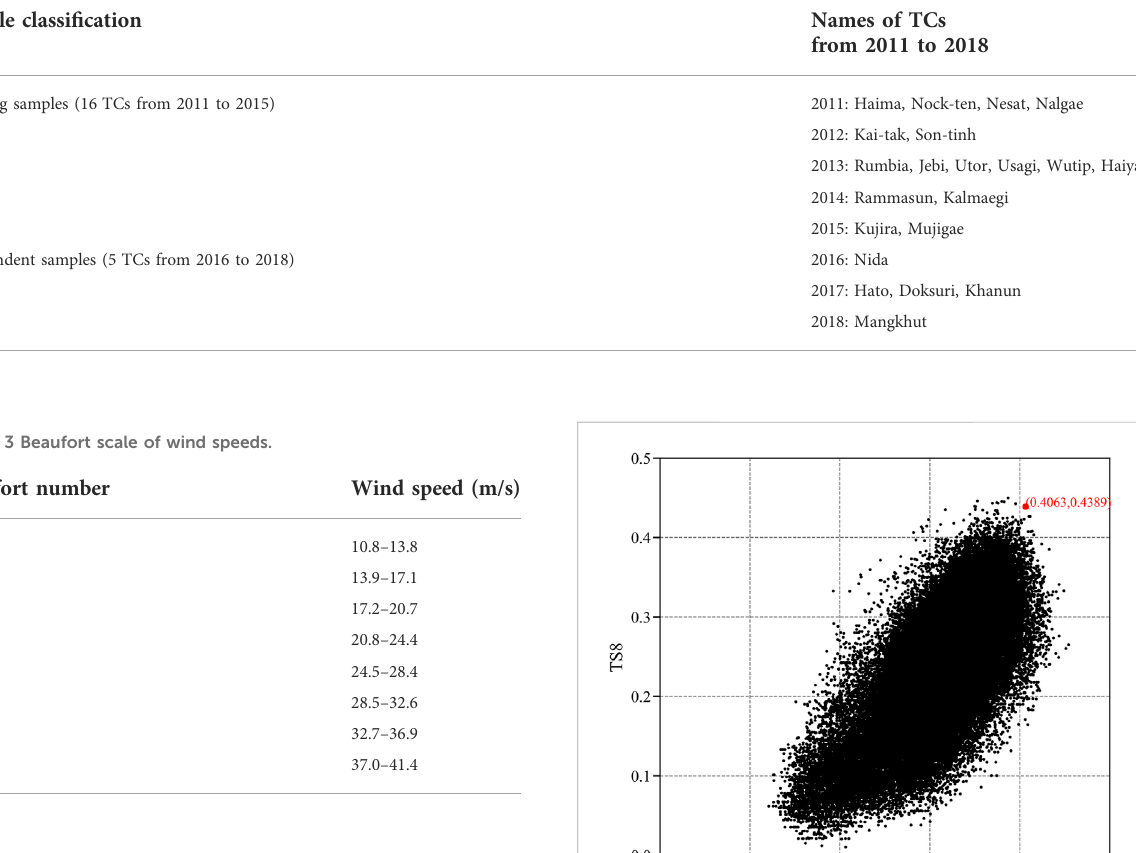
TABLE 2 List of training samples and independent samples for TCs.